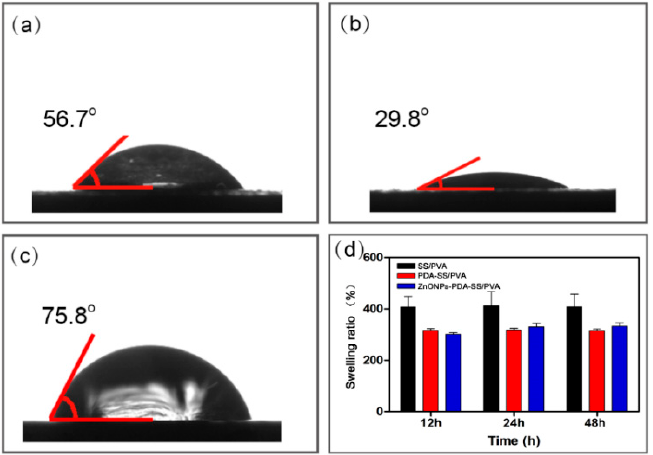
Figure 5. Water contact angle and swelling property of SS/PVA ( a ), PDA-SS/PVA ( b ), and ZnO NPs-PDA-SS/PVA films ( c ). Swelling ratio of these films ( d ) ( n = 3 per group).